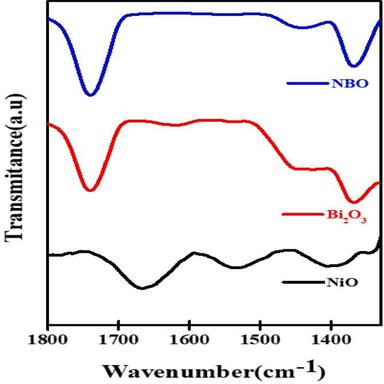
IR spectra of Pyridine and pure NiO, Bi2O3 and NBO materials.